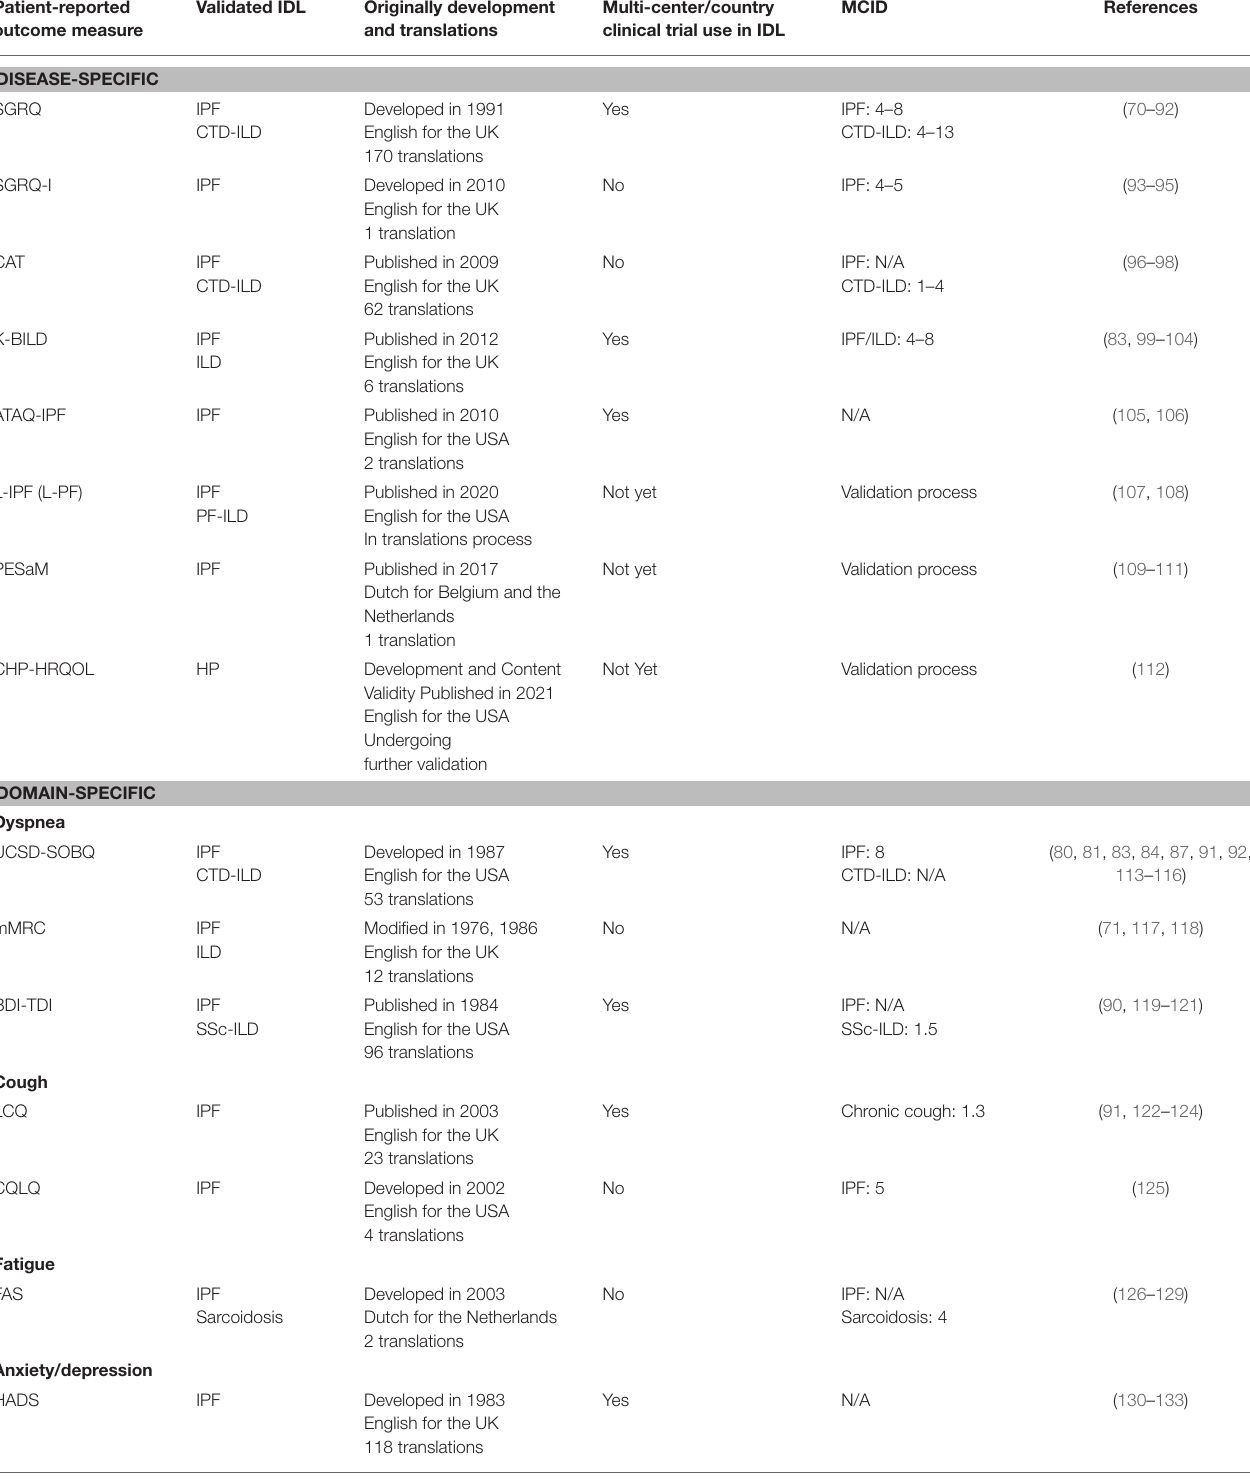
TABLE 1 | Cross-cultural adaptation and linguistic validation of PROMs in ILD. Patient-reported outcome